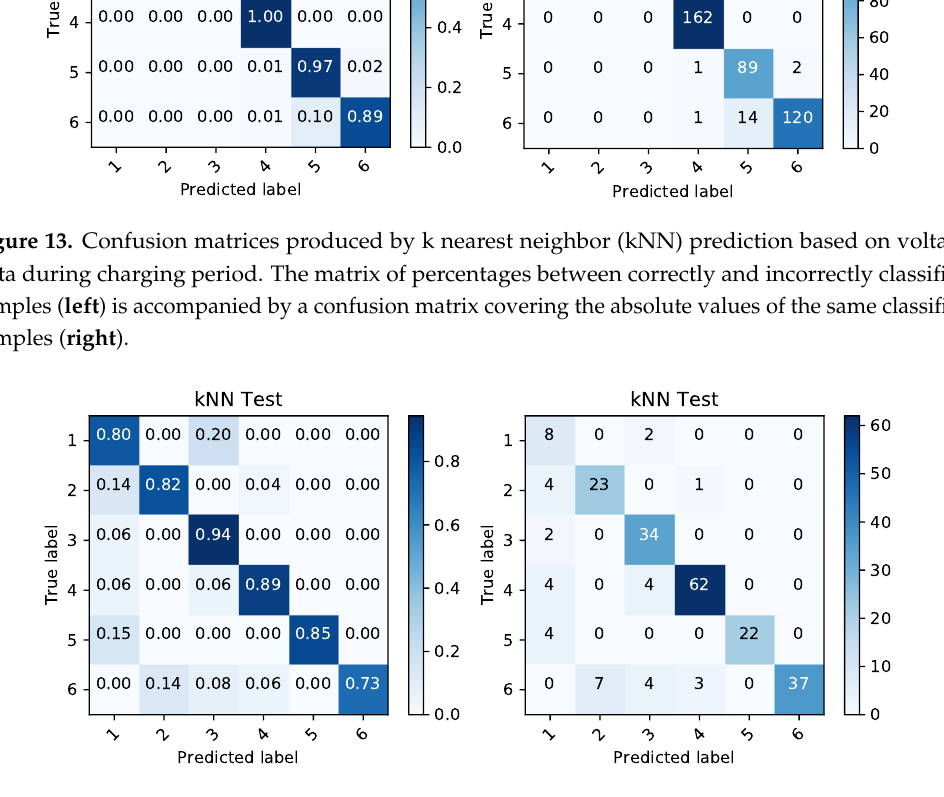
Figure 14. Confusion matrices produced by kNN prediction based on temperature data during discharging period. The matrix of percentages between correctly and incorrectly classified samples ( left ) is accompanied by a confusion matrix covering the absolute values of the same classified samples ( right ).